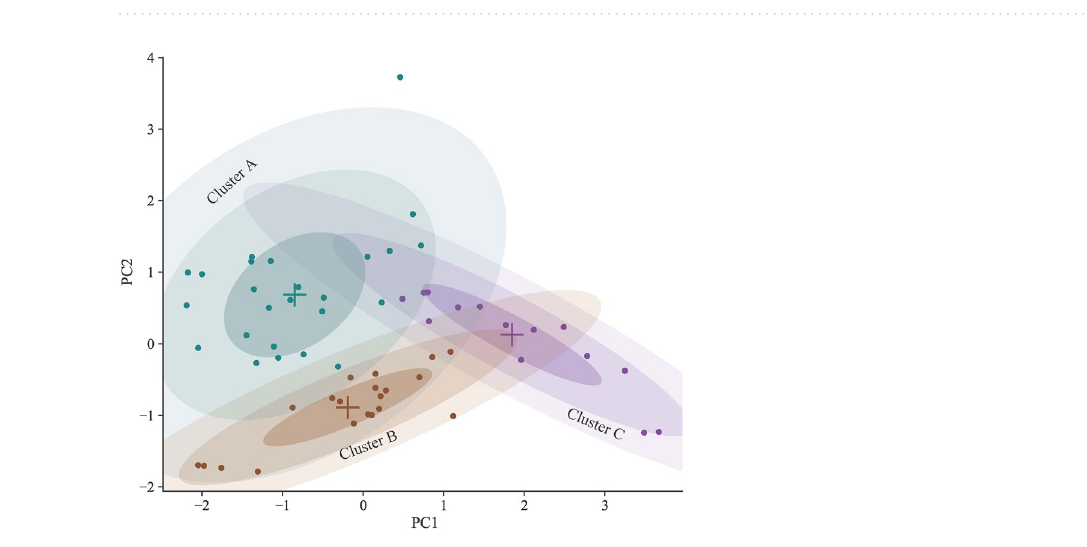
Figure 12. Relative hyper area (RHA) of candidate Pareto fronts (PF) obtained by algorithms for ( a ) BK15, ( b ) BK40 and ( c ) BK50.